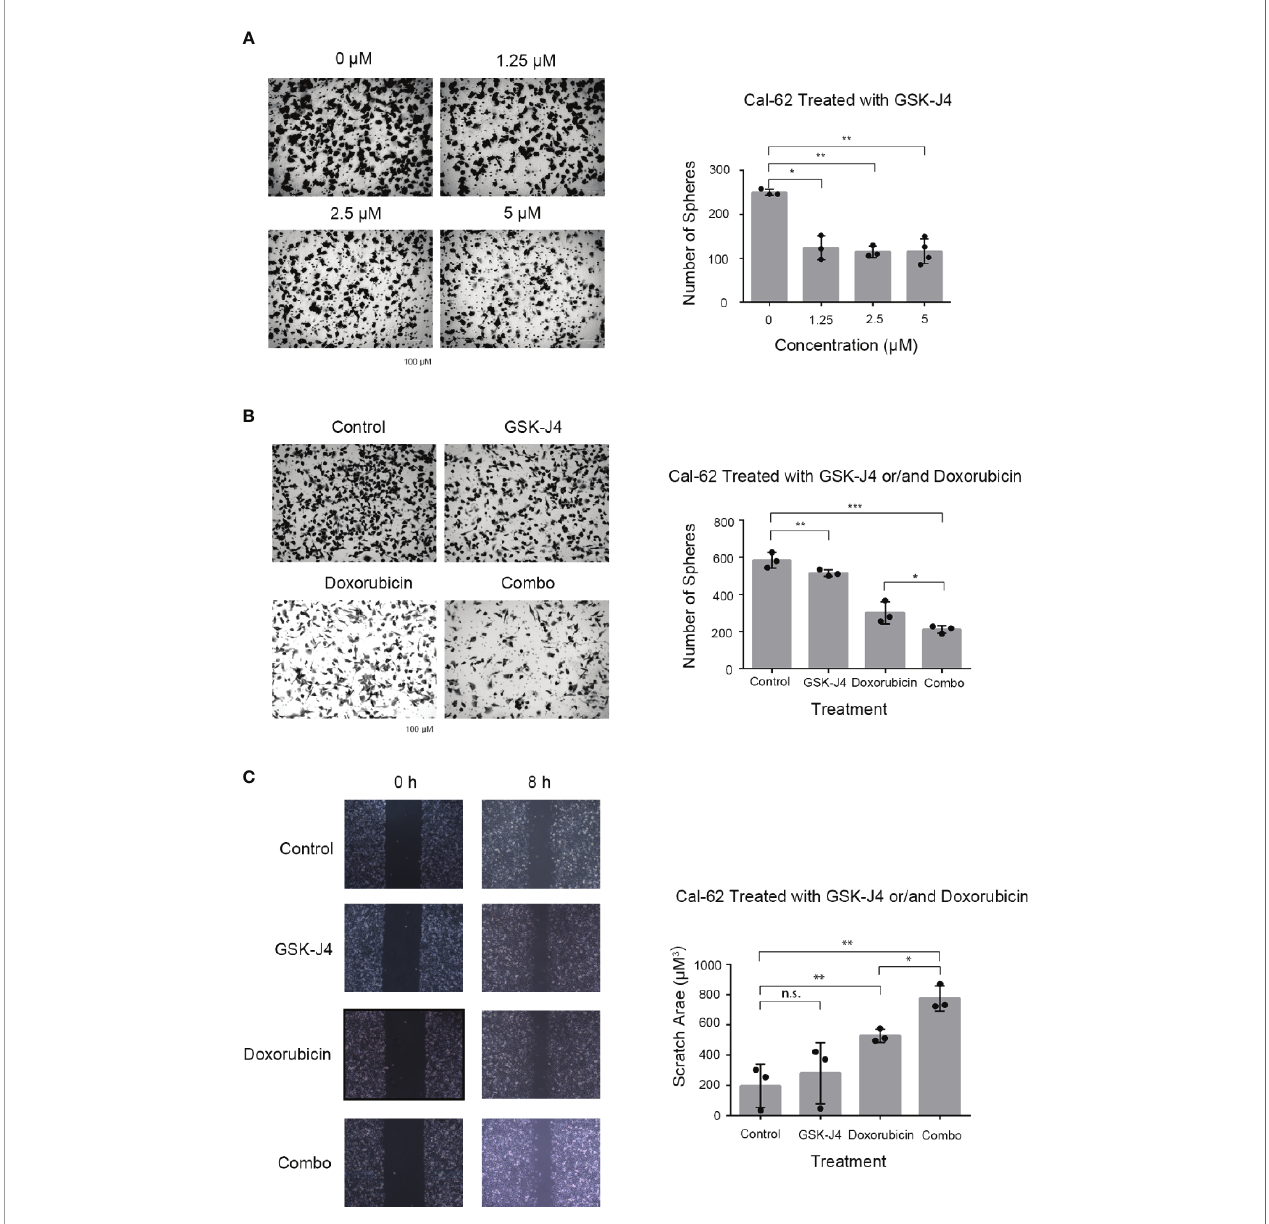
FIGURE 3 | Effects of GSK-J4 and Doxorubicin on Invasion and Migration of the Cal-62 Cell Line. The invasion ability of GSK-J4 in different concentration on Cal-62 cell line (A) the effect of GSK-J4 combined with doxorubicin on the invasion ability (B) and migration ability (C) of the Cal-62 cell line. Scale bar, 100 m M. n.s., no statistical difference. *, p < 0.05, **, p < 0.01, ***, p <